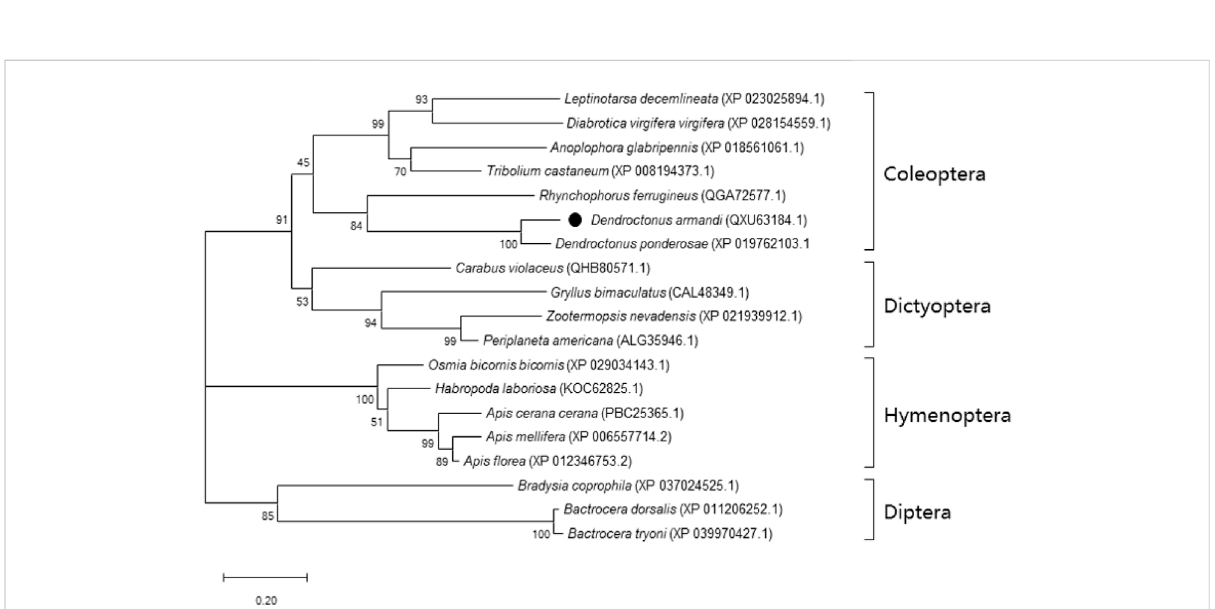
FIGURE 2 Phylogenetic analysis of DaSK with other insect species. The phylogenetic tree was constructed by the maximum-likelihood method using the amino acidic substitution model WAG in MEGA 6.0. Bootstrap values (500 replicates) are indicated next to the branches and GenBank accession numbers are shown in parentheses. The black dot indicates D. armandi